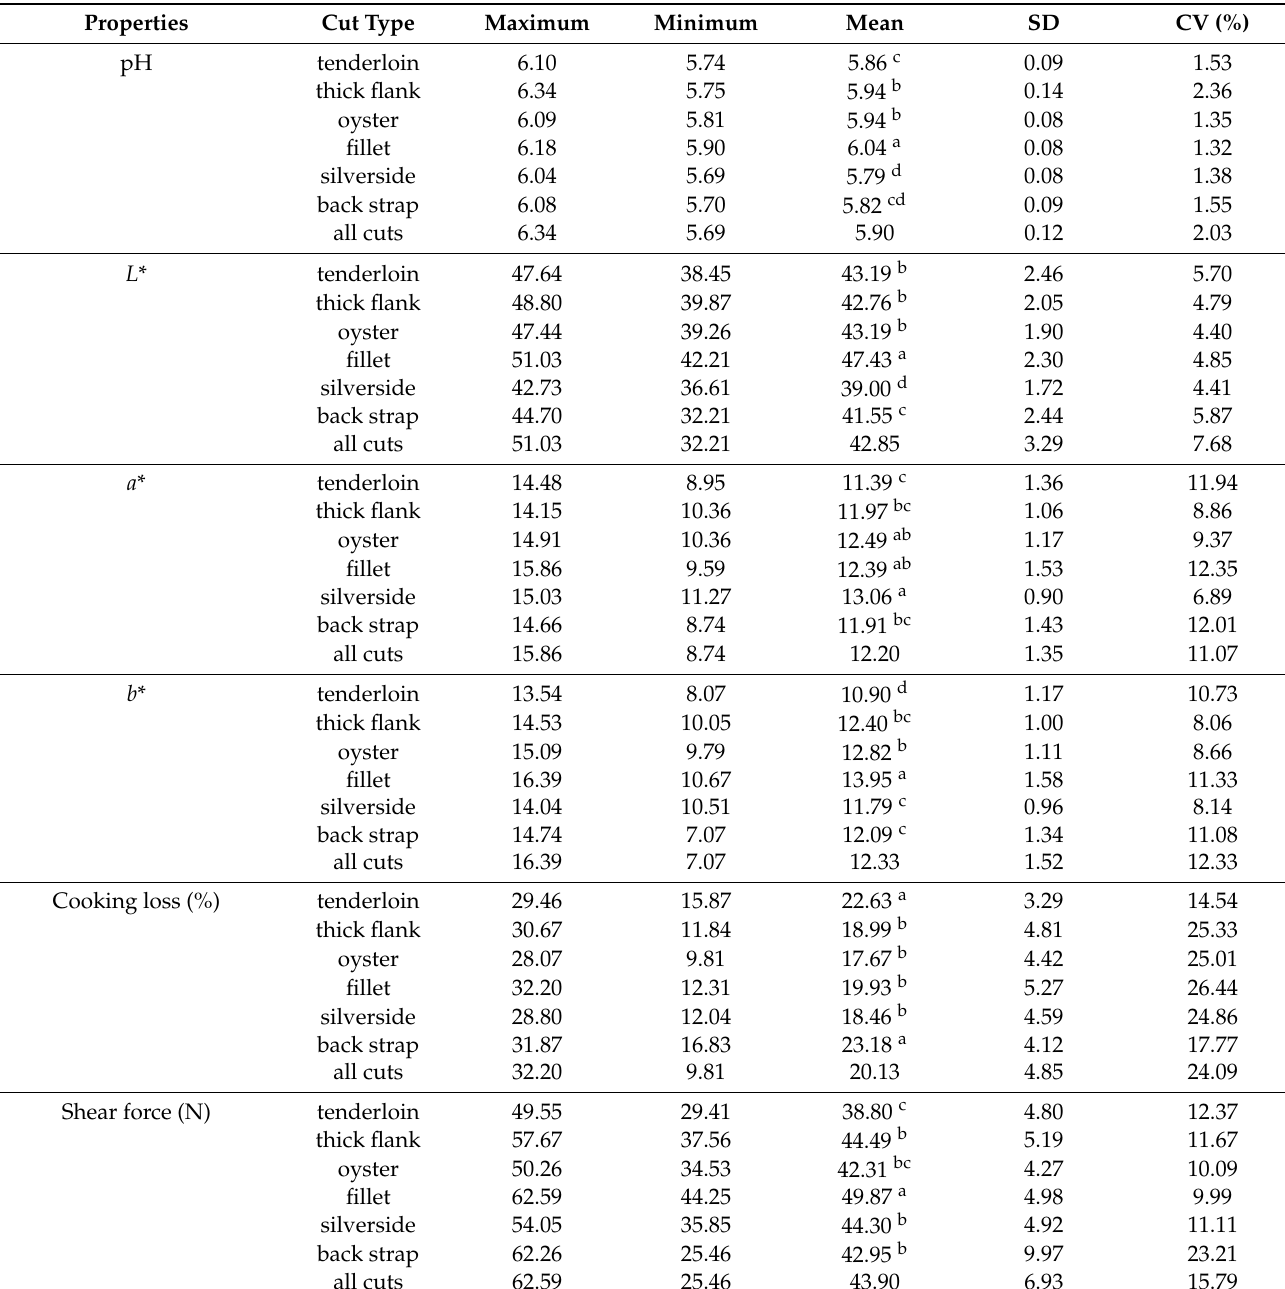
Table 1. Descriptive statistics of the physicochemical properties characteristics for different meat cut types.